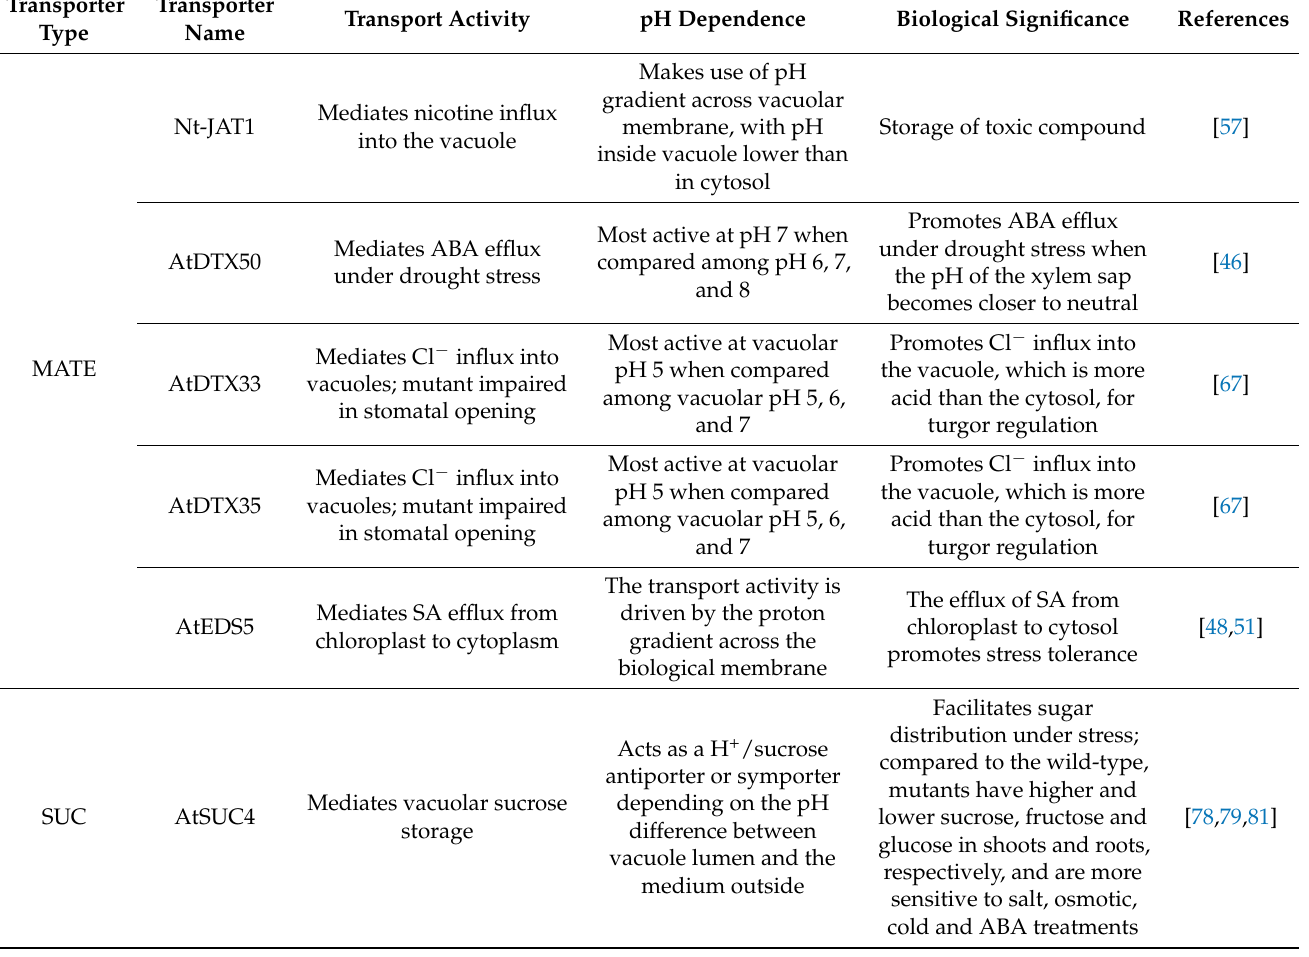
Table 1. Examples of the activities, pH dependence, and the biological significance of